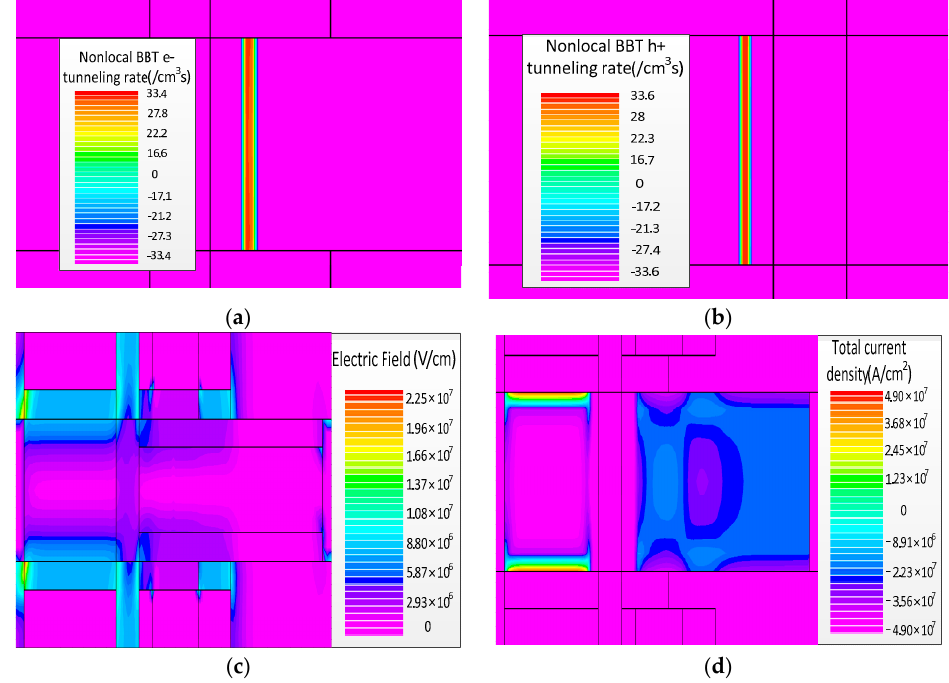
Figure 2. ( a ) Nonlocal band to band tunneling (BTBT) rate of electrons; ( b ) nonlocal band to band tunneling (BTBT) rate of holes; ( c ) electric field distribution in DMGE-HJLTFET; ( d ) total current density of DMGE-HJLTFET.